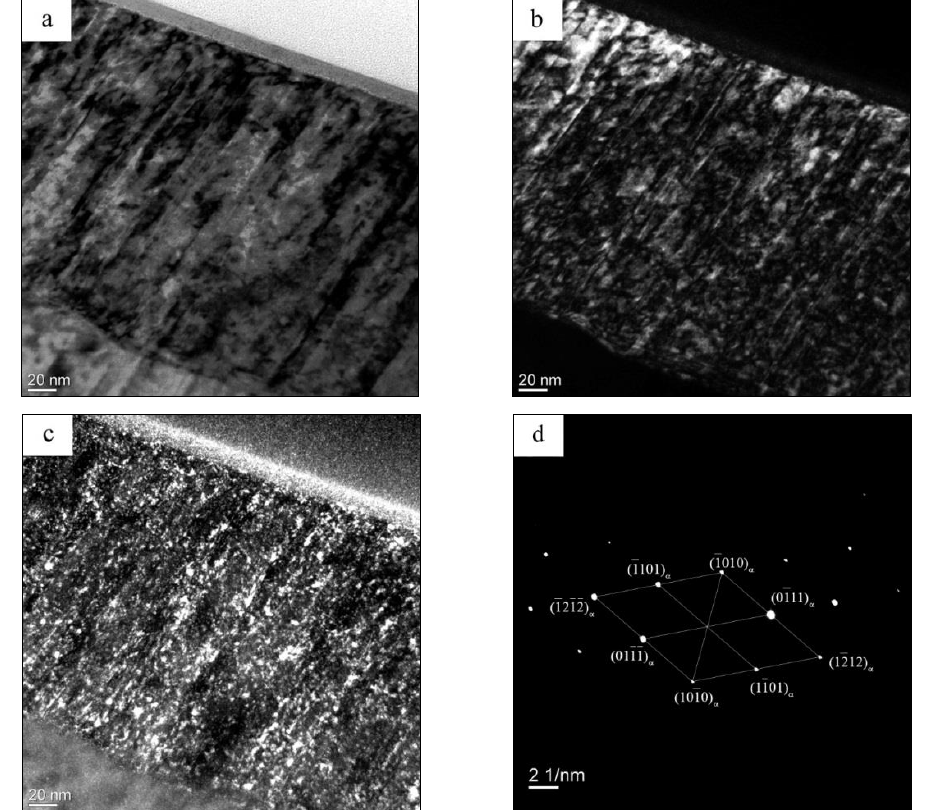
Figure 4. TEM images of the EBM Ti-6Al-4V samples after PIB irradiation: structure of the surface layer 1: bright-field image ( a ), dark-field images in the ( 0111 ) ( b ), ( 1010 ) ( c ), reflections, corresponding microdiffraction ( d ).